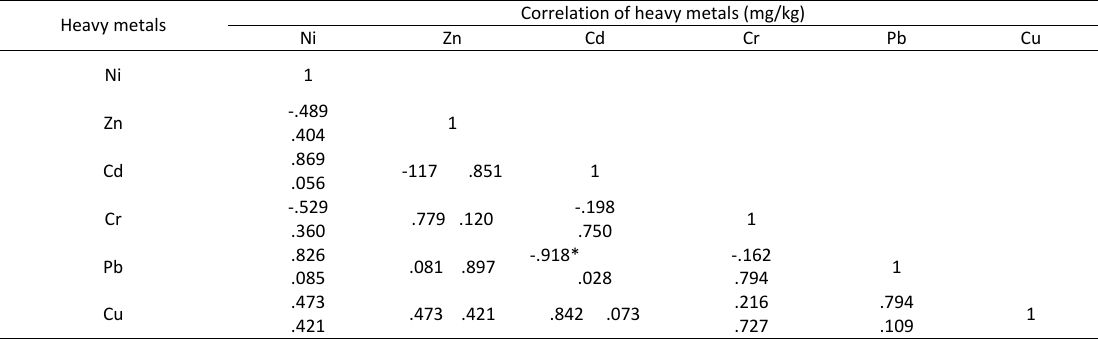
Table 6: Correlation between the selected heavy metals and Dumpsite at 20 – 40 cm Depth